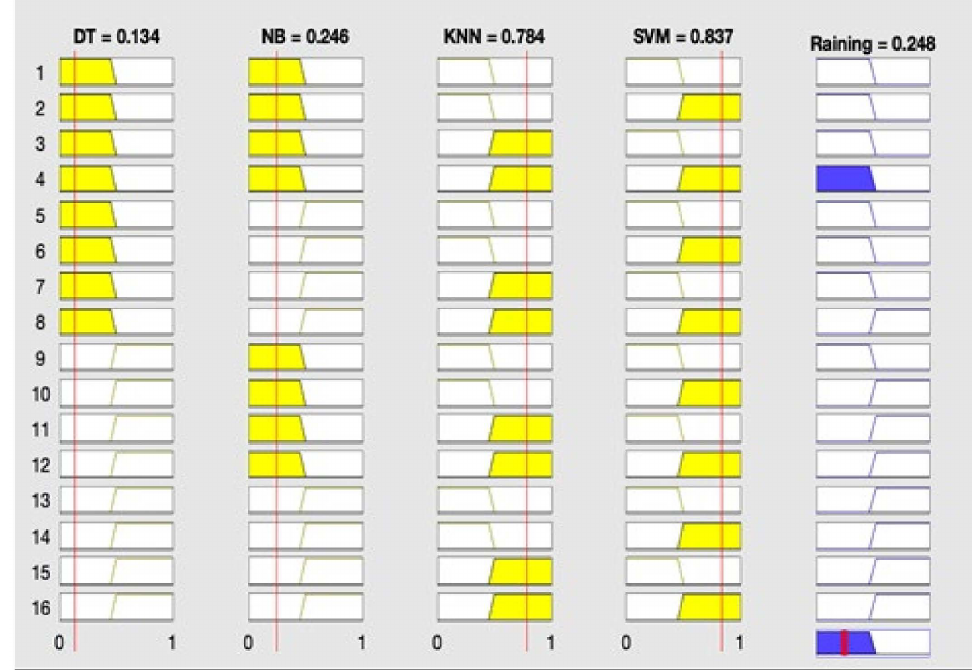
Figure 4. Result of proposed framework: rainfall =